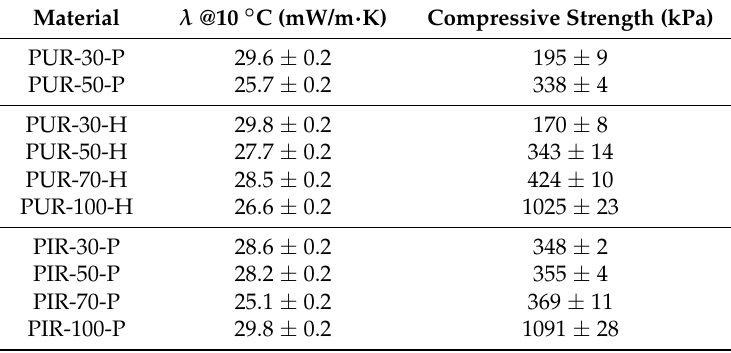
Table 2. Results of foam characterization.